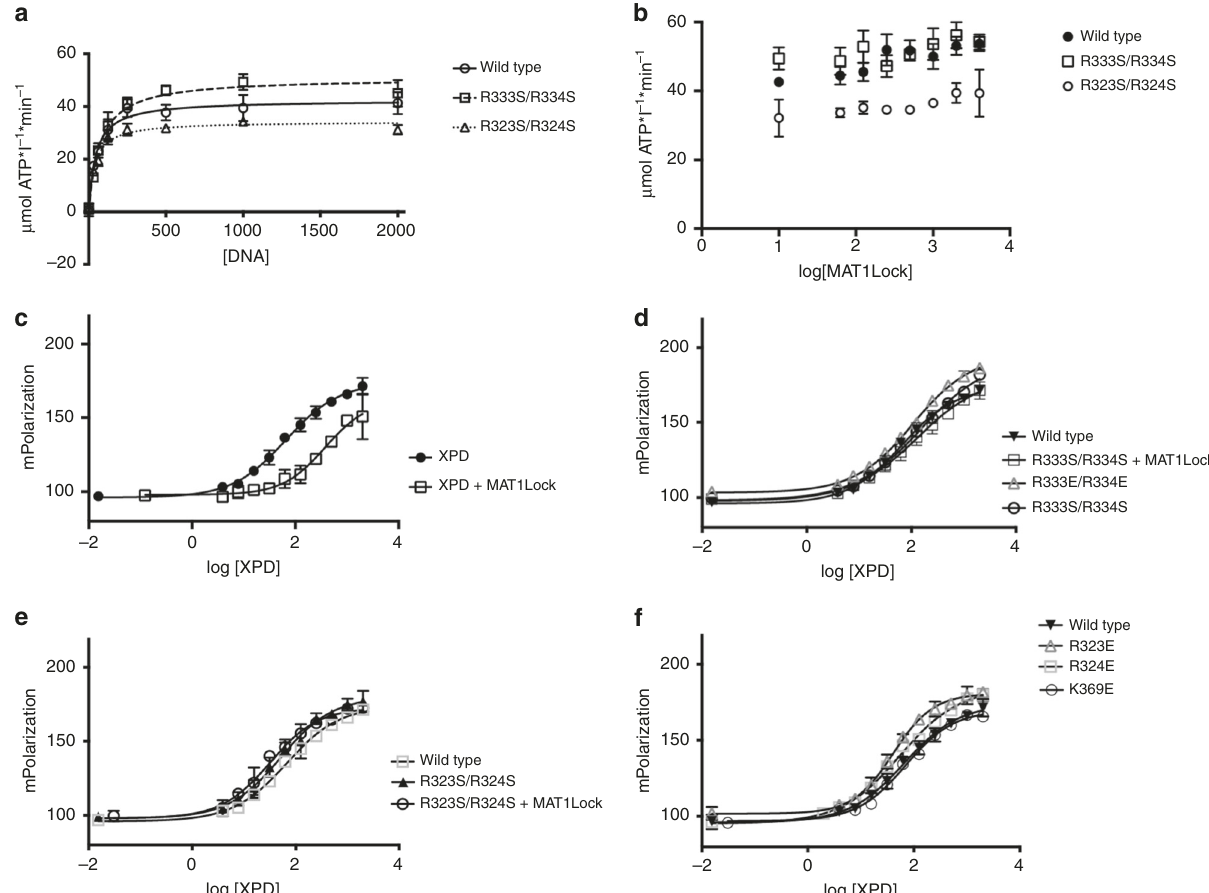
Fig. 4 DNA dependent ATPase activity and DNA binding parameters of ctXPD variants. a ssDNA dependent ATPase activities of ctXPD and selected variants using increasing amounts of DNA. b ctMAT1Lock in fl uence on ssDNA induced ATPase of wild-type ctXPD and ctXPD variants. c – f Fluorescence anisotropy measurements utilizing wild-type ctXPD and ctXPD variants in the presence or absence of equimolar amounts of ctMAT1Lock and a splayed duplex DNA as bait. Average values and SD are shown and were derived from two biological replicates combined in at least three technical